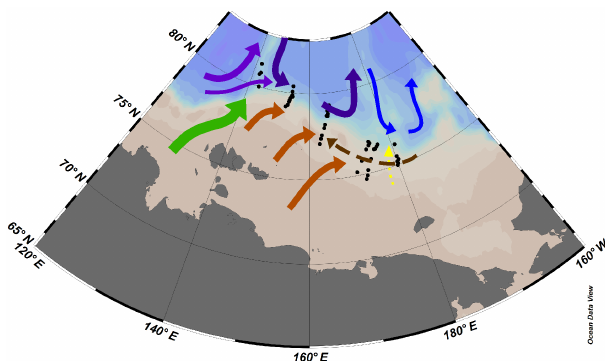
Figure 14. Summary of deduced circulation. Green arrow shows the runoff spreading in the surface out north of the New Siberian Islands. The light brown illustrates the export of nutrient-rich wa- ter from the shelf into the deep basin at a salinity of around 33 and the dark brown interrupted line the nutrient-rich water of a salin- ity around 34.5. The dark blue arrows in the deep basin show the intermediate deep (500–1500m depth) boundary currents. The yel- low dotted line illustrates the deep water plumes off the shelf break. Map drawn using Ocean Data View (Schlitzer,